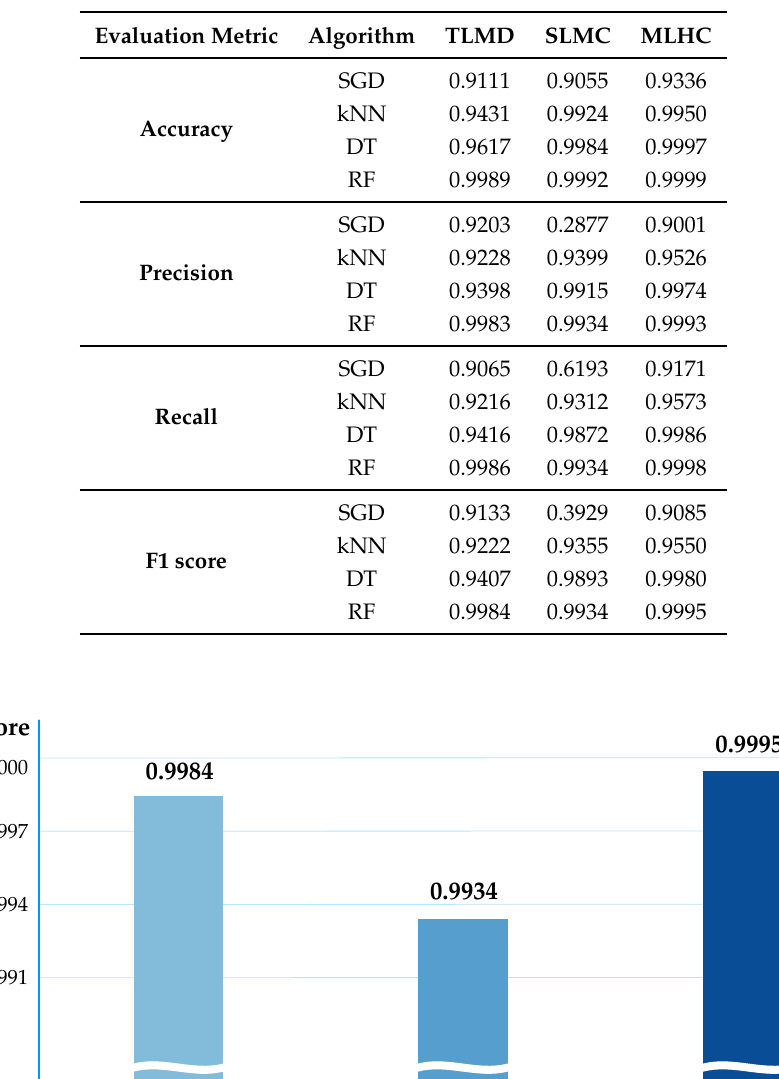
Table 6. Simulation results for detection rate.